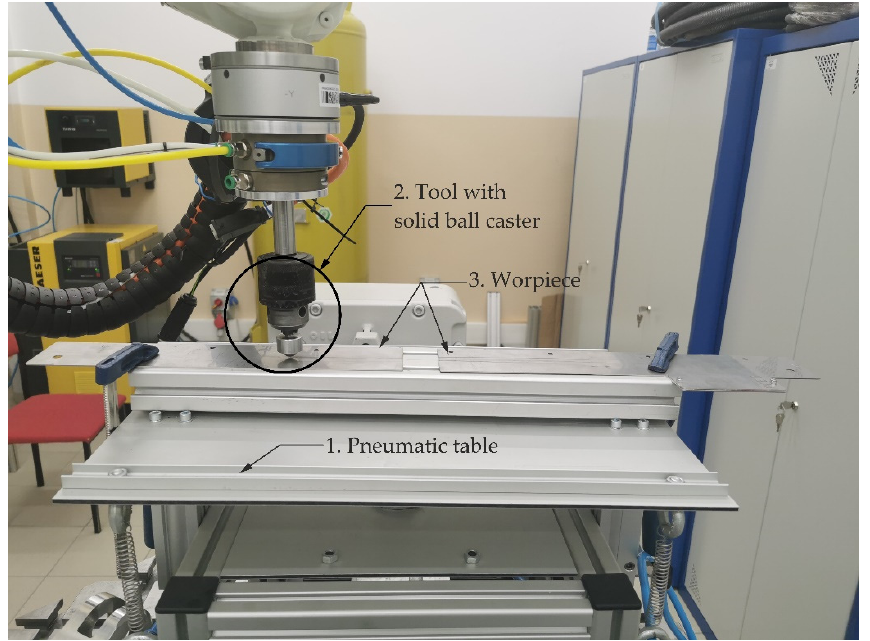
Figure 5. Photo of the test stand.